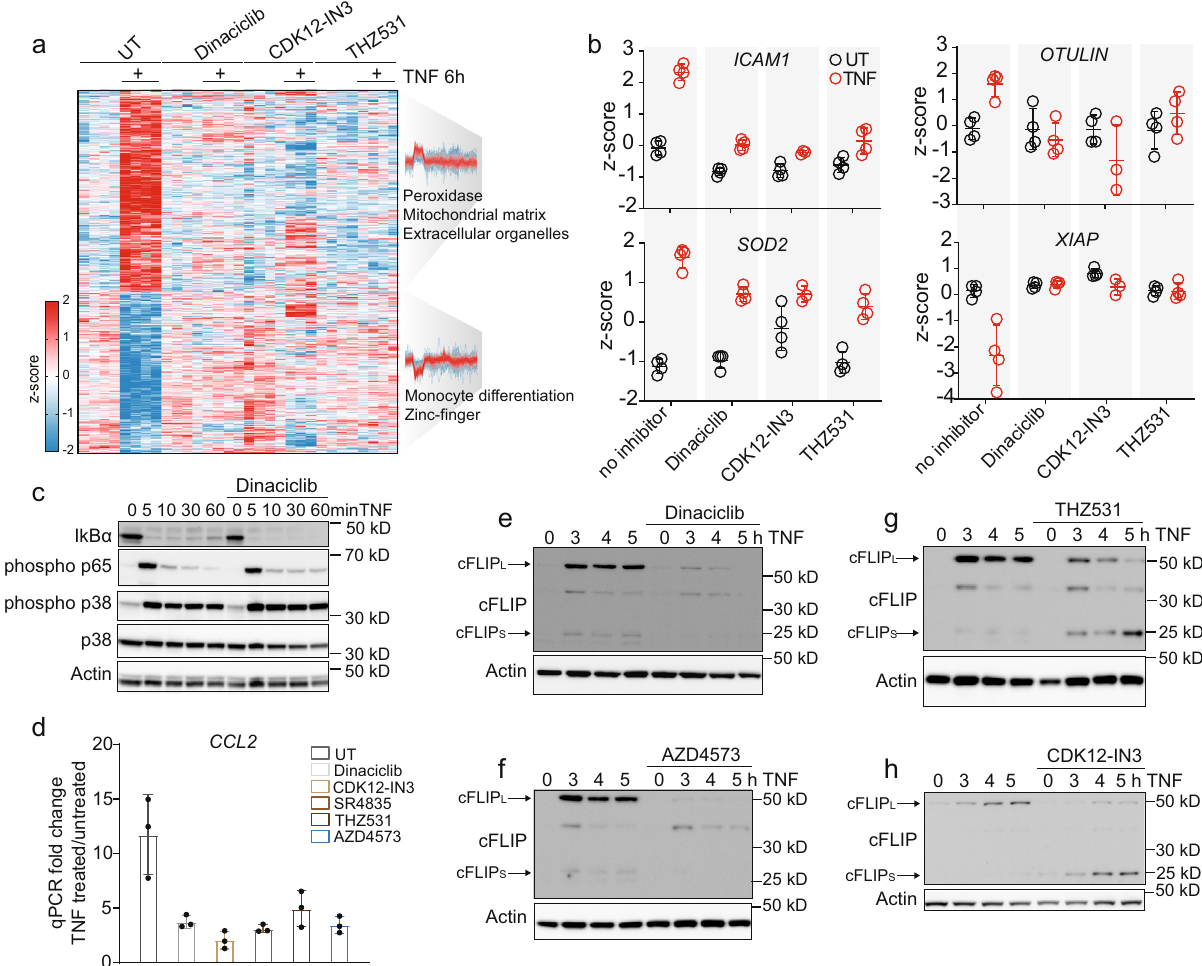
Fig. 5 CDK9 and CDK12/13 inhibitors potently reduce transcription of TNF-target genes. a Heatmap of z-scored protein intensities signi fi cantly changed upon TNF treatment for 6 h in U937 cells (FDR < 0.05). Cells were additionally treated with Dinaciclib (6 nM), CDK12-IN3 (60 nM), and THZ531 (400 nM). Fisher ’ s exact test on up- and downregulated protein clusters (two-sided Student ’ s t -test, FDR < 0.001). The pro fi les are color-coded according to their distance from the respective cluster center (red is close to the center, blue is further away from the center). b Z-scored protein levels of selected TNF-target genes and members of the TNF-signaling pathway (±SD, n = 4 biologically independent experiments). c Immunoblot of U937 cells treated with TNF alone and in combination with the pan-CDK inhibitor Dinaciclib. Proteins were blotted for I κ B α , phosphorylated p65, phosphorylated, and total p38 and β -actin (loading control) ( n = 2 biologically independent experiments). d qPCR of CCL2 of U937 cells treated for 4 h with TNF alone or in combination with CDK inhibitors Dinaciclib (6 nM), CDK12-IN3 (60 nM), SR4835 (160 nM), THZ531 (200 nM) and AZD4573 (6 nM) (±SD, n = 3 biologically independent experiments). e – h U937 cells treated with TNF alone and in combination with CDK inhibitors (concentrations as in d) were blotted for cFLIP and β -actin ( n = 2 biologically independent experiments). Source data are provided as source fi